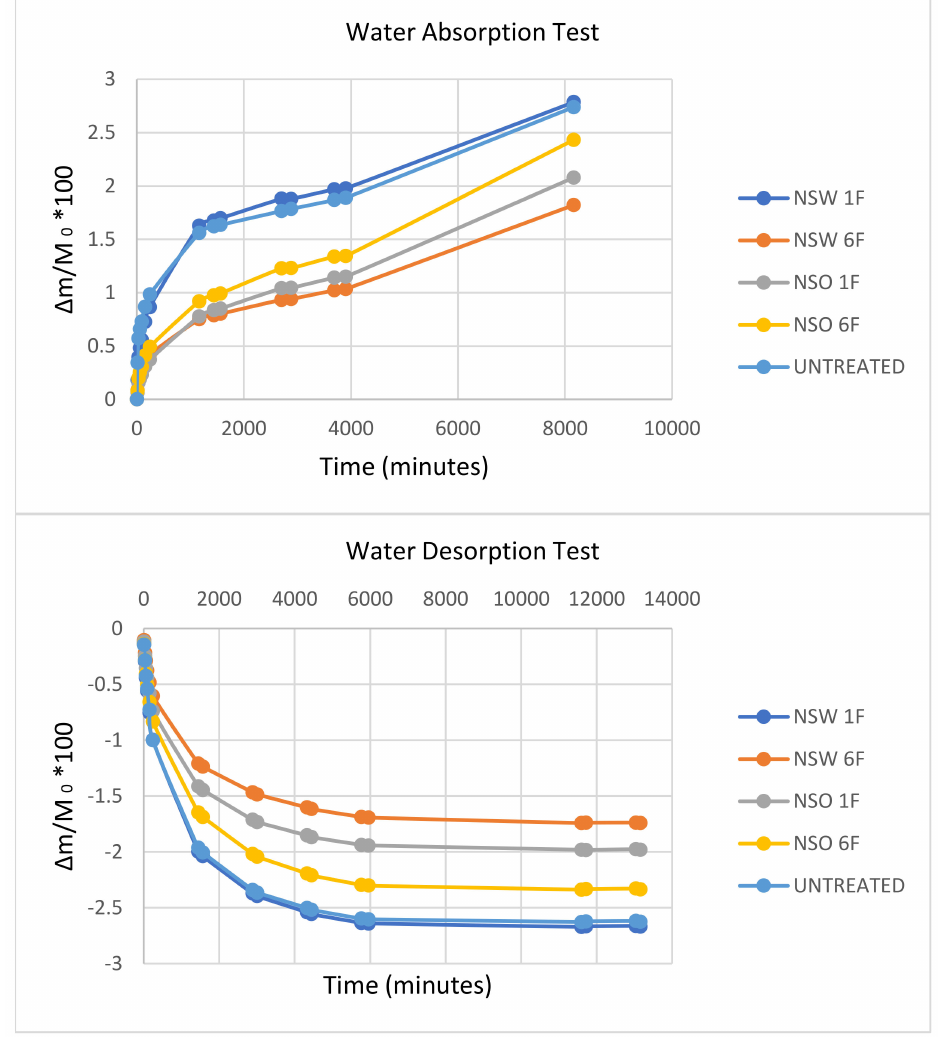
Figure 5. Water Absorption and Desorption